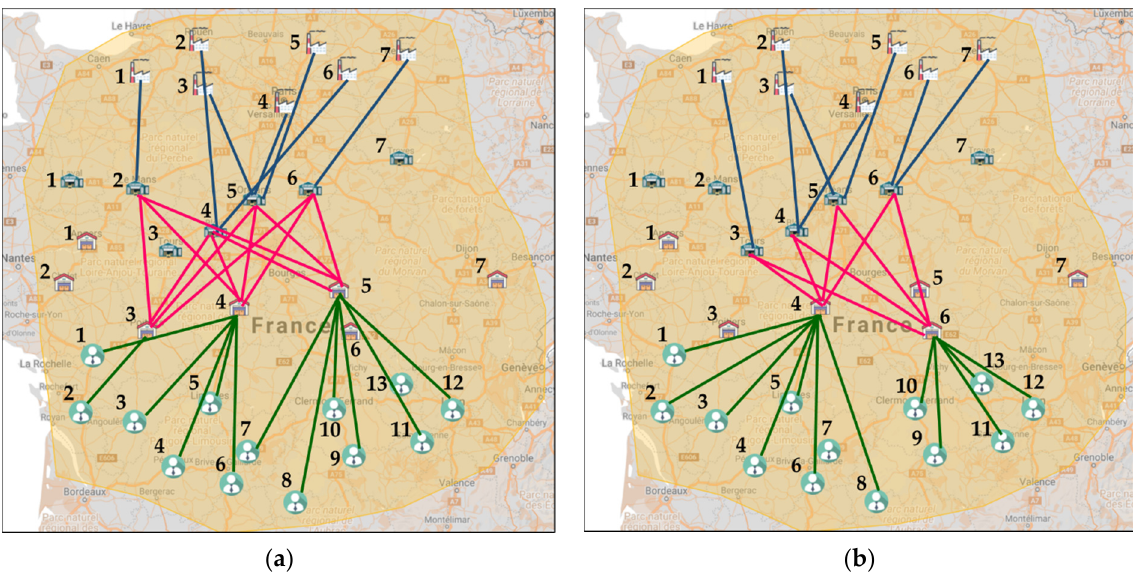
Figure 14. Optimal network configurations of Sc2 scenario using the GA. ( a ) Sc2_eco; ( b ) Sc2_env.